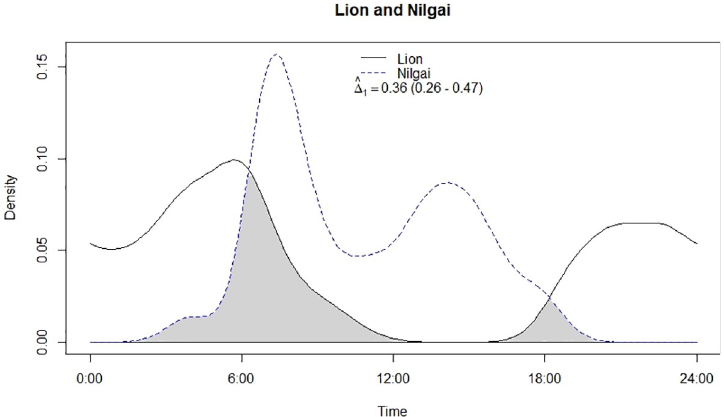
Fig 9. Temporal overlap between lion and nilgai.